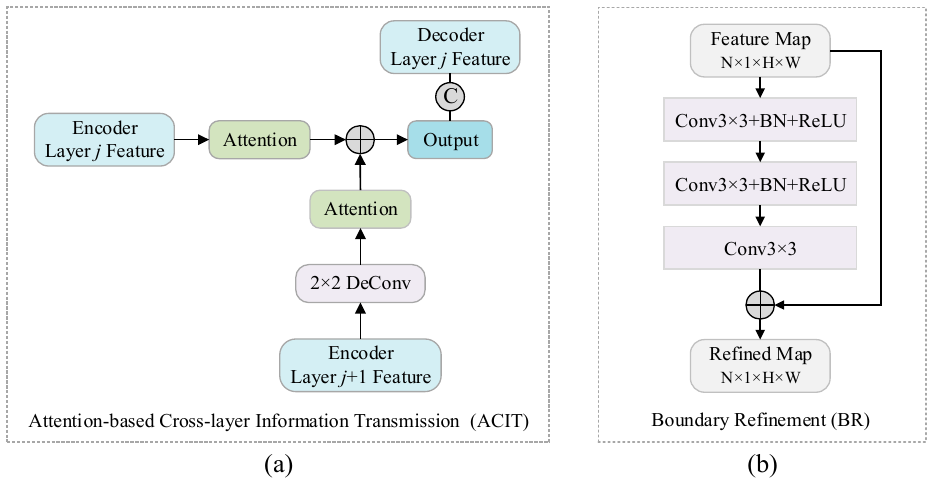
Figure 4. The architecture of the proposed ( a ) ACIT module and ( b ) BR block.